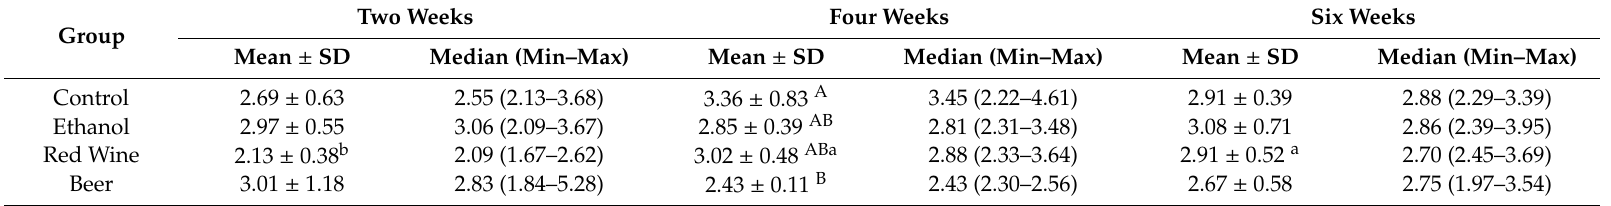
Table 9. Glutathione transferase (GST) activity ( µ M / min per mg of protein) in the groups of experimental rats stratified by a group and experiment duration.